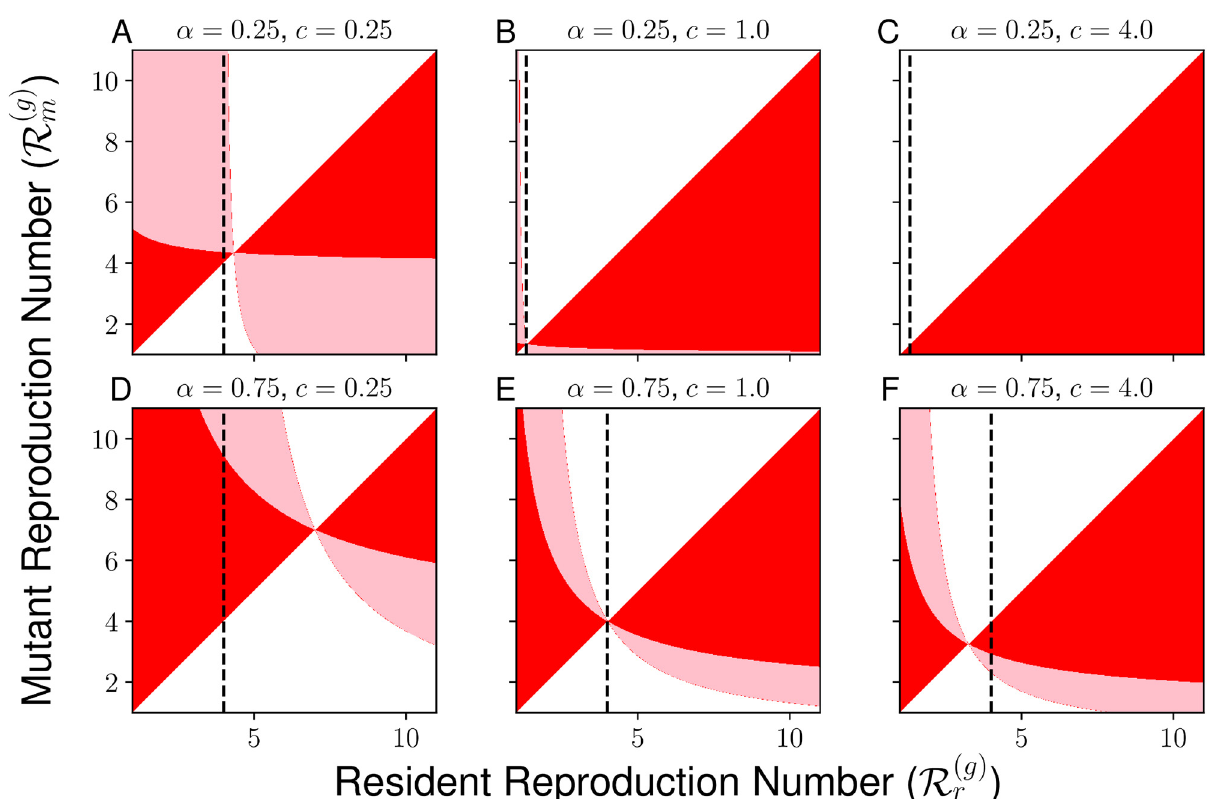
Fig 4. Pairwise invasibility plot with mutual invasbility or lack thereof shown. In each panel, horizontal axis describes the reproduction number R r of the resident strategy, while the vertical axis describes the reproduction number R corresponding to the mutant strategy. The color of a given point m describes the outcome of pairwise competition between the resident and mutant strategy. Points displayed in white describe pairs of strategies in which the resident strategy dominates the mutant strategy: a small cohort of the mutant will fail to invade a population primarily consisting of resident strategy, while a small cohort of the resident strategy will successfully invade a population primarily consisting of the mutant strategy. Points in red describe pairs of strategies in which the mutant strategy dominates the resident strategy: the mutant strategy will successfully invade the resident when rare, and a population of the mutant strategy will resist the invasion of a small cohort of the resident strategy. Points displayed in pink describe a case in which neither the resident nor mutant strategy dominates the other: the mutant invades the resident when rare and the resident invades the mutant when rare. The dashed line describes the socially-optimal strategy R ð g Þ , while the point of intersection of two components of the red region corresponds opt . All areas of mutual invasibility are off the diagonal except when arbitrarily close to the evolutionarily-stable to the evolutionarily-stable strategy R ð g Þ ESS strategy ESS, which implies that dimorphism will not evolve if mutations are small.